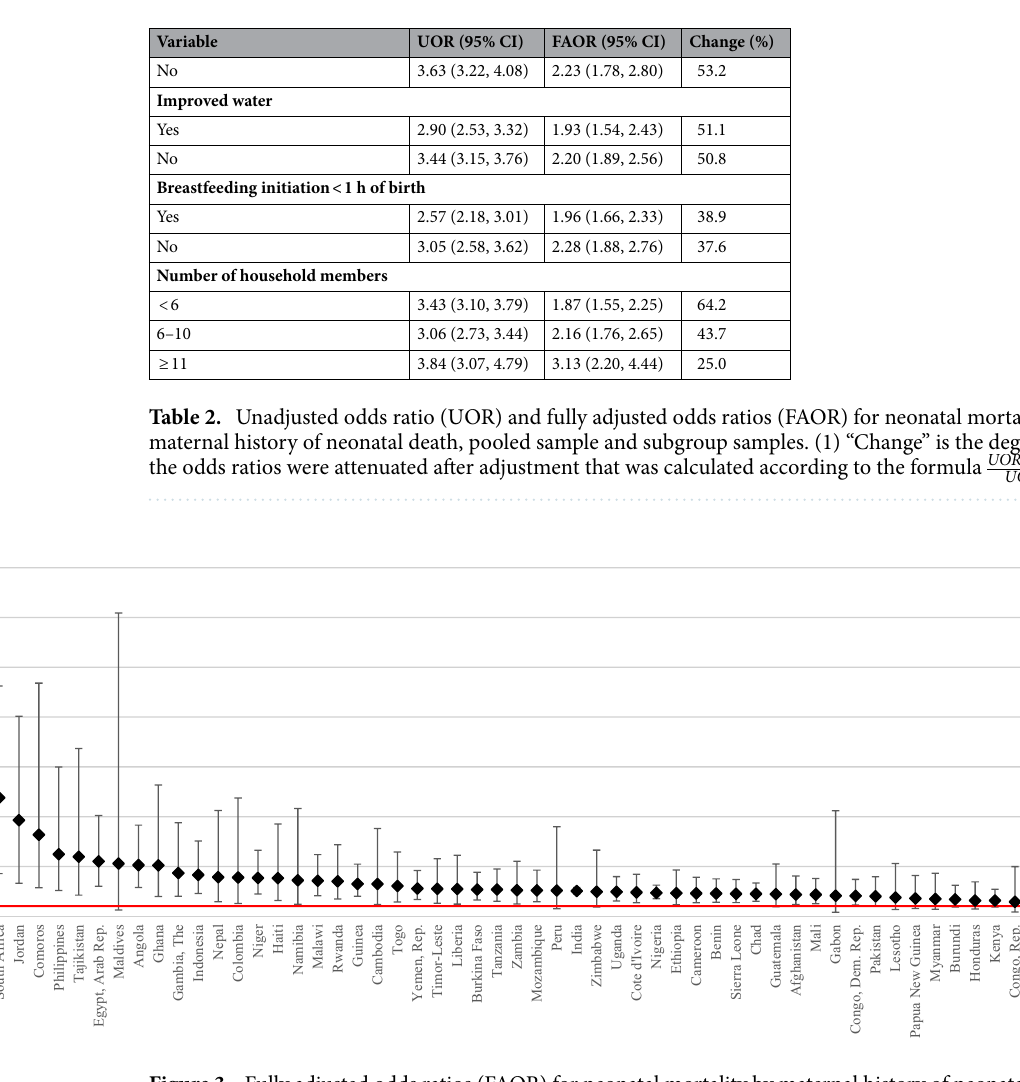
Figure 3. Fully adjusted odds ratios (FAOR) for neonatal mortality by maternal history of neonatal death, by